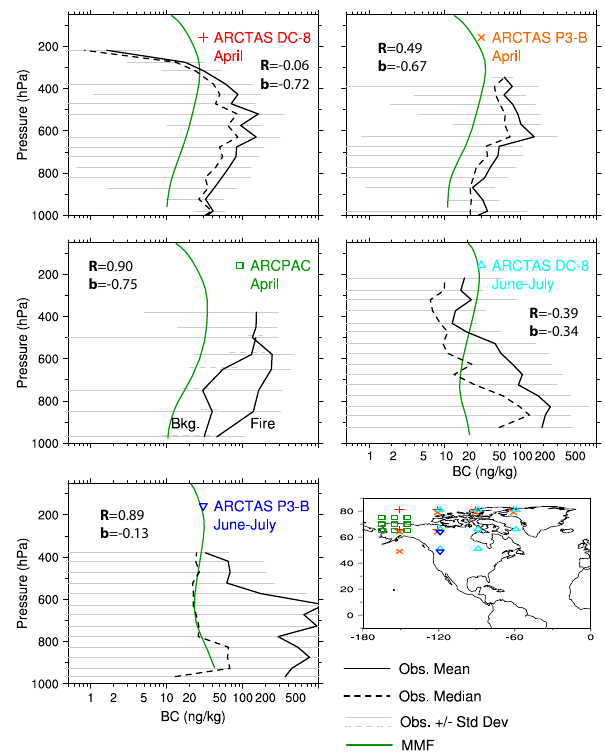
Fig. 16. The same as Fig. 15, but for BC vertical profiles in the high latitudes over two campaigns (ARCTAS: NASA Arctic Research of the Composition of the Troposphere from Aircraft and Satellite; ARCPAC: NOAA Aerosol, Radiation, and Cloud Processes affect- ing Arctic Climate). Observations are average for the respective campaigns, and are measured by three different groups: the NASA group for ARCPAC; the University of Tokyo group for ARCTAS; and the University of Hawaii group for ARCTAS. See Table 7 in Koch et al. (2009) for flight